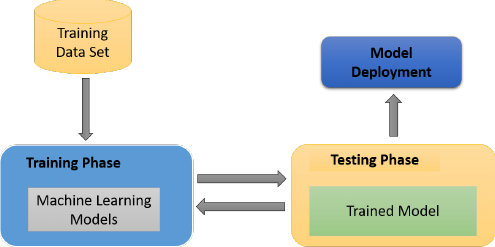
Figure 4. Process of Machine Learning.